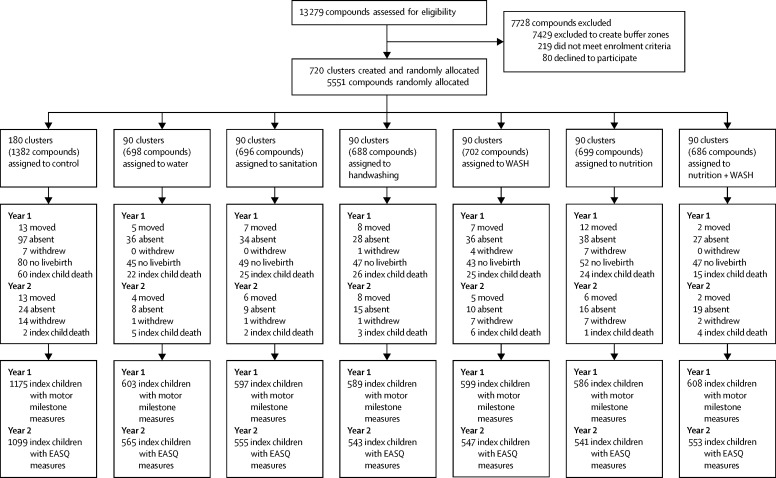
Trial profileNumbers are children except where specified. Attrition was only at the child level; no cluster dropped out. WASH=water, sanitation, and handwashing. EASQ=Extended Ages and Stages Questionnaire.